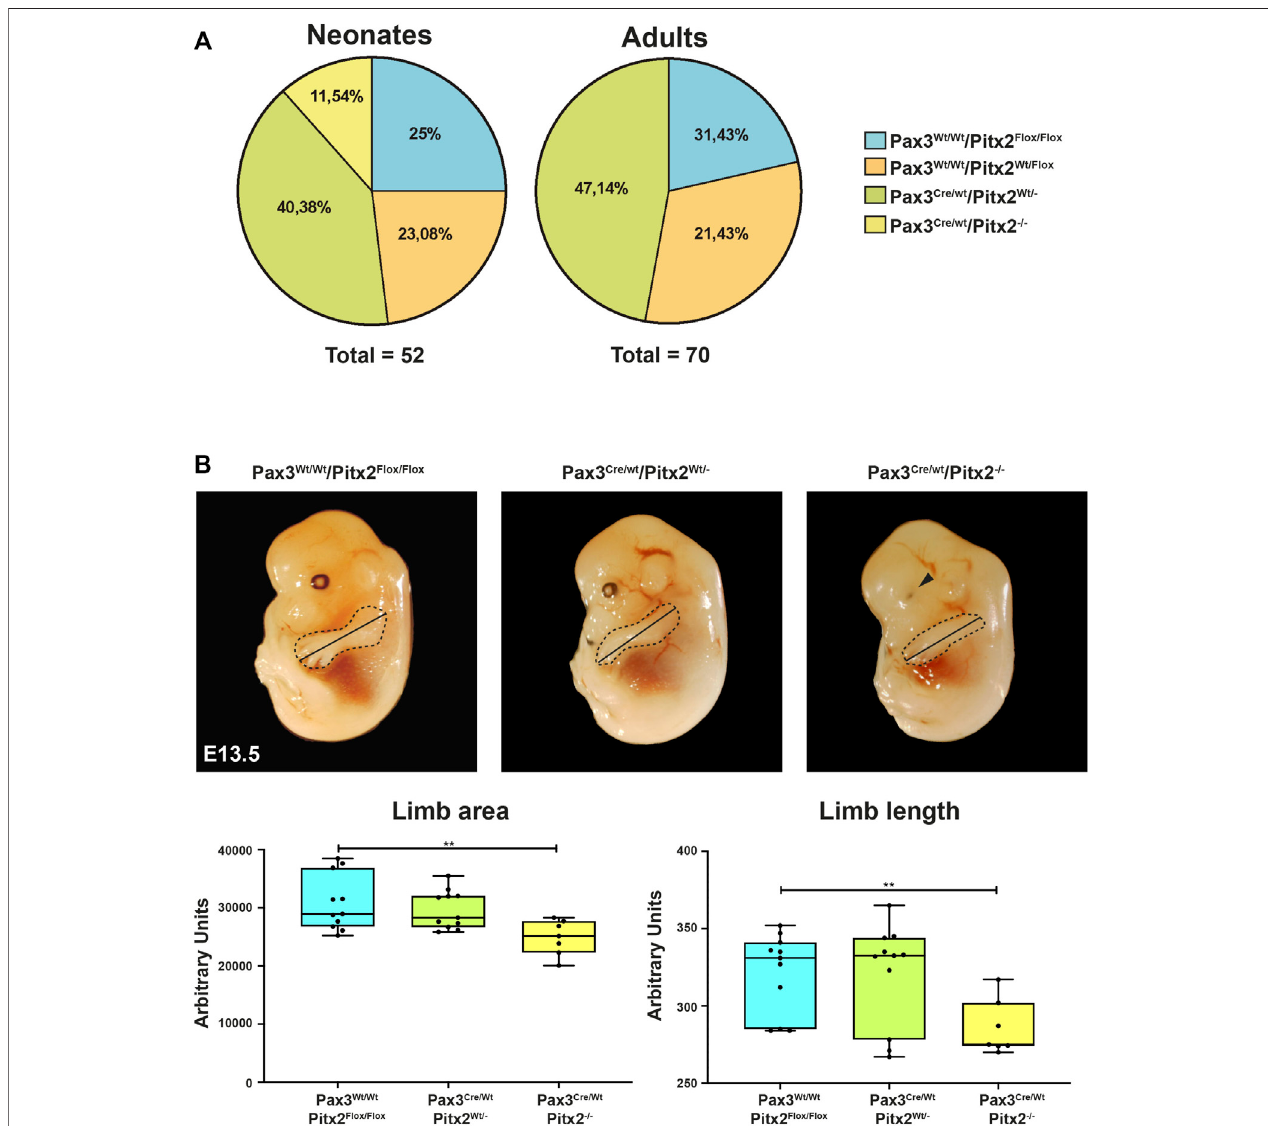
FIGURE 1 | Analysis of Pax3 Cre/Wt Pitx2 − / − conditional mutants. (A) Mendelian ratios and survival rates for Pax3 Wt/Wt /Pitx2 Flox/Flox , Pax3 Cre/Wt /Pitx2 Flox/Wt , Pax3 Cre/Wt /Pitx2 Wt/- and Pax3 Cre/Wt Pitx2 − / − mice at neonatal ( n = 52) and adult stage ( n = 70). (B) Schematic representation of morphometric analyses in Pax3 Cre/Wt / Pitx2 − / − mutant embryos (E13.5) carried out by evaluating limb length (black line) as well as limb areas (delineated by dotted area) by using the image J software (NIHImage) in a total of 40 embryos ( n = 10 for Pax3 Cre/Wt /Pitx2 − / − , n = 13 for Pax3 Cre/Wt /Pitx2 Wt/- and n = 17 for Pax3 Wt/Wt /Pitx2 Flox/Flox ). Quanti fi cation of limb length, limb area and body are shown.** p < 0.01. Ocular defects are indicated by a black arrow.